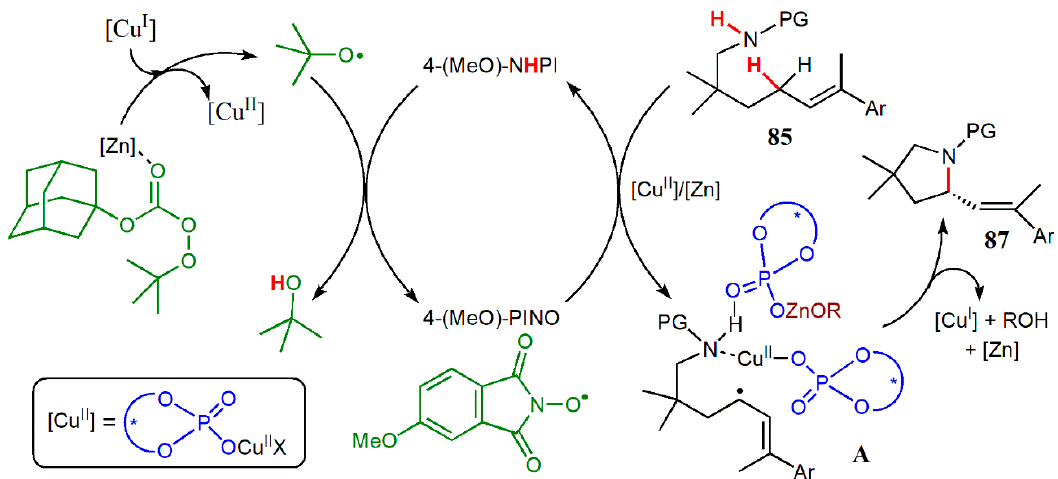
Figure 27. The mechanism proposed for the intramolecular amination of allylic C–H bonds.